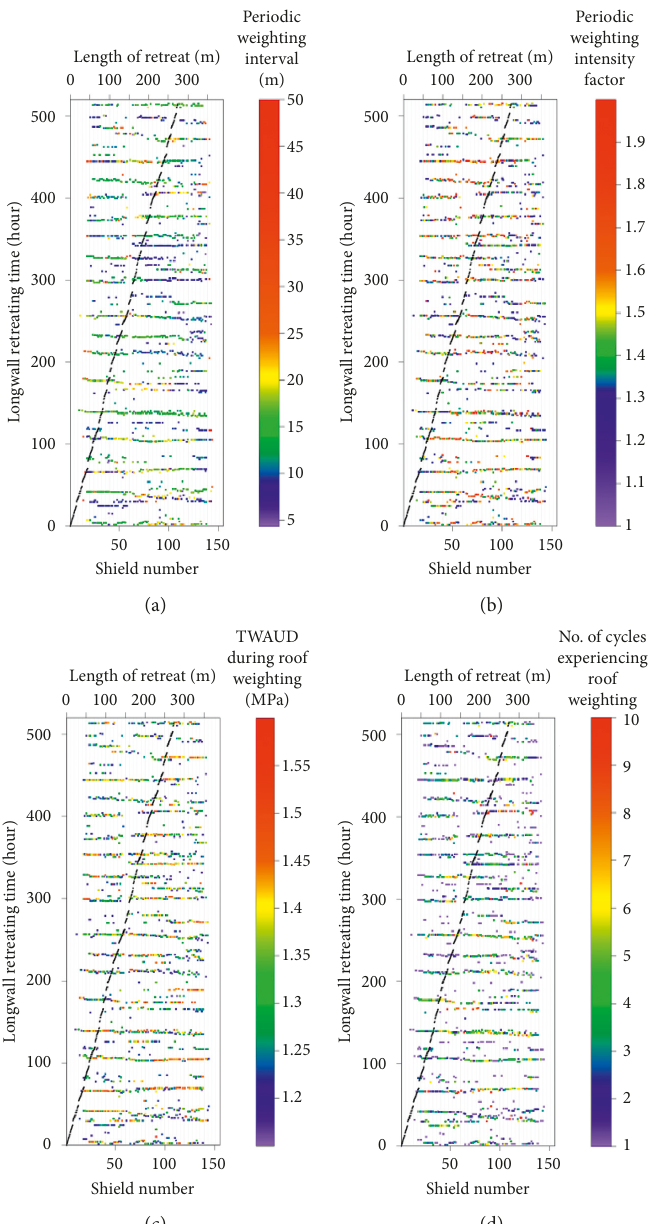
Figure 5: Evolution of (a) periodic weighting interval, (b) periodic weighting intensity factor, (c) average TWASD during consecutive roof weightings, and (d) number of cycles experiencing roof weighting, with longwall retreating time in Panel LW22306 of Bulianta mine. The upper x -axis denotes length of